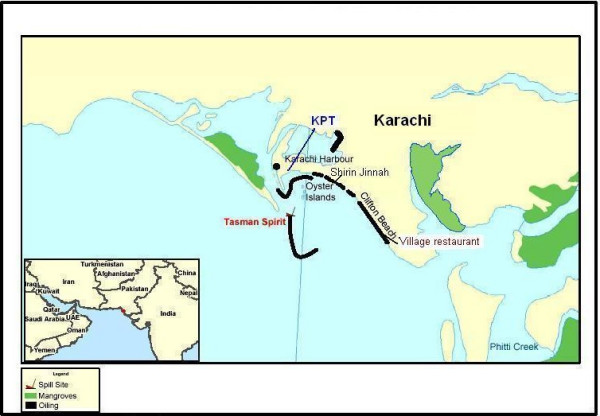
Map of the shoreline covered with crude oil residues after crude oil spill from Tasman Spirit in Karachi, Pakistan 2003 (Source: Sindh Environmental Protection Agency).